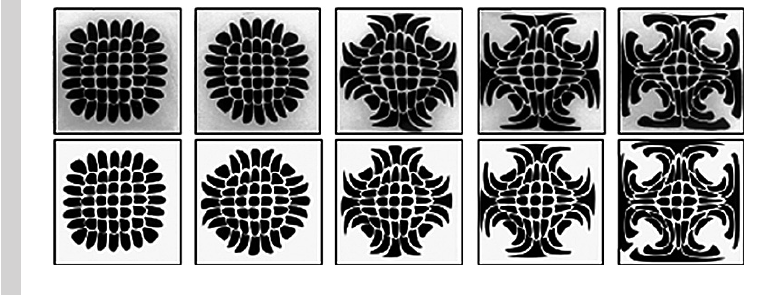
Figure 7 (left): Interface deformation evo- lution of three different ini- tial (column wise) structures in the rectangular channel. Each subsequent figure shows the progression after a multiple of 5 L/D. The last column contains the extrud- ed structure after 50 L/D. The flow rate was 2.48 cc/s. Figure 8: Comparison of experimen- tal (top row) and numerical results (bottom row) for the progression of a 49-strand polystyrene structure as it flows down a square chan- nel. Excellent agreement is